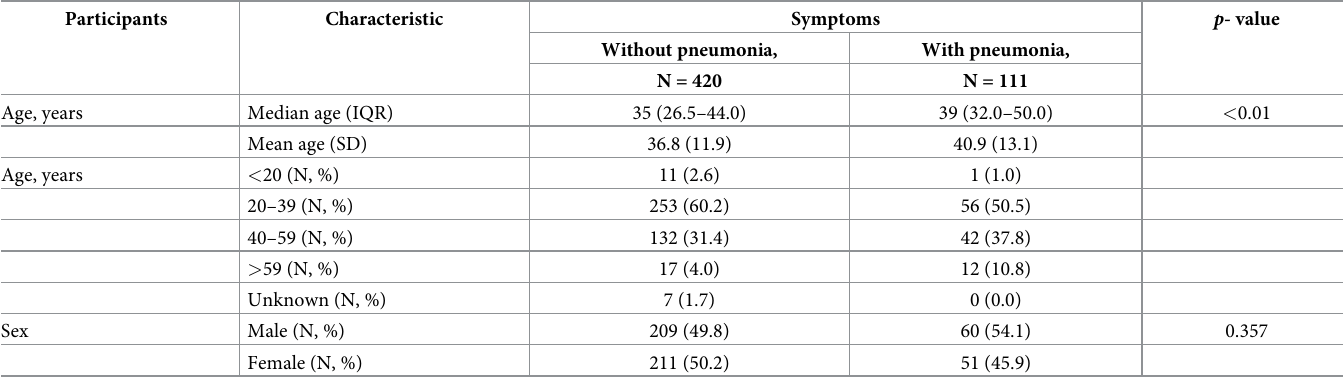
Table 1. Demographic data of participants in this